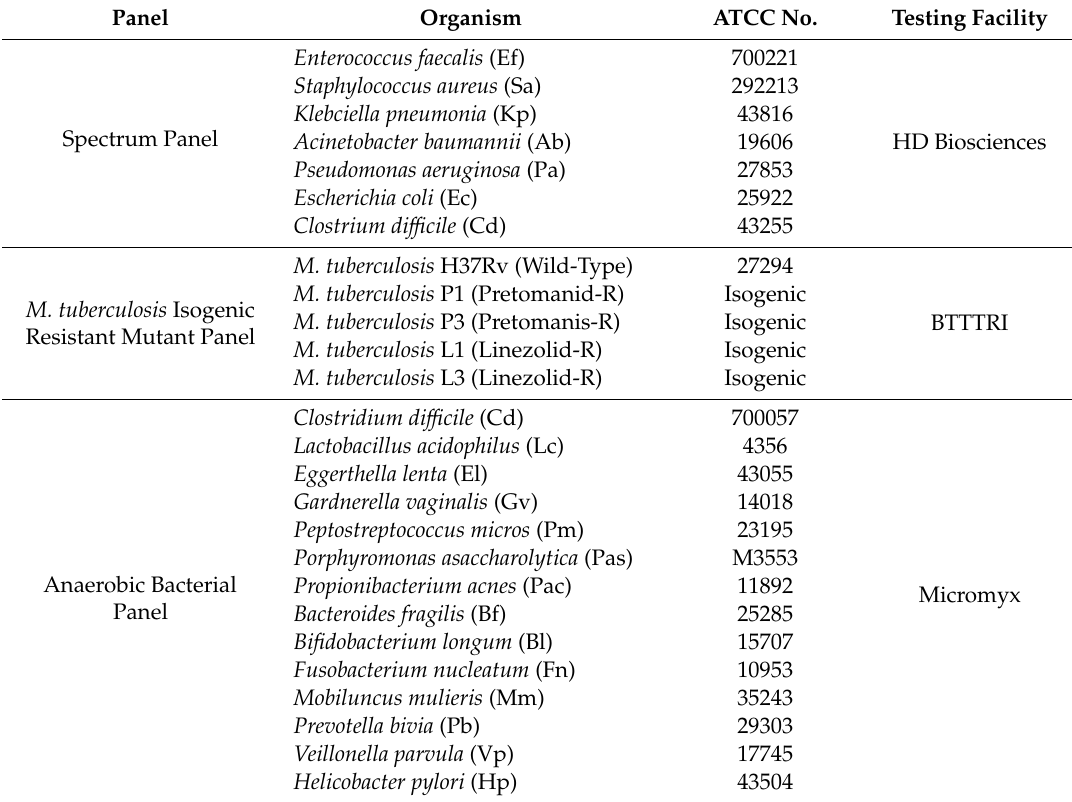
Table 4. List of bacterial strains used in the current